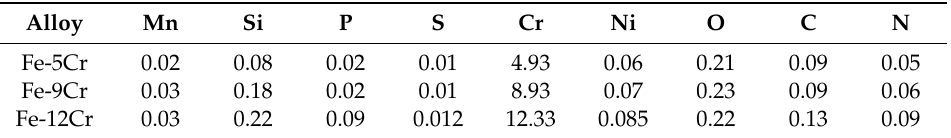
Table 1. Composition of the investigated alloys in